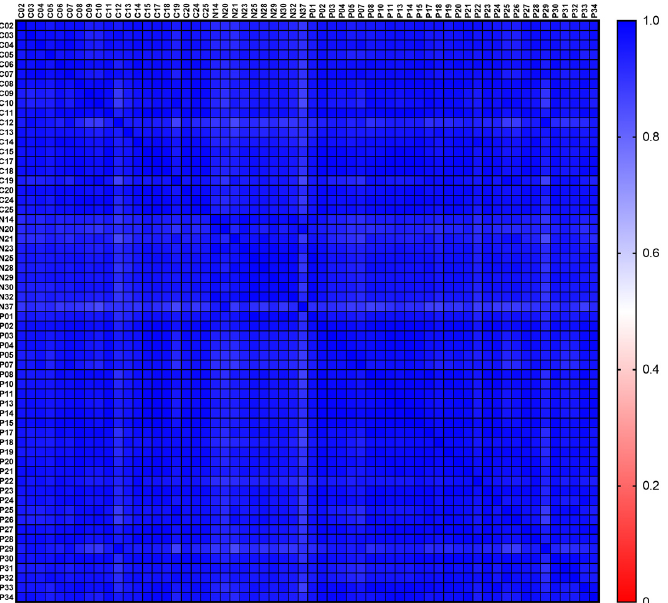
Figure 1. Normalized sample-to-sample correlation matrix. The spearman r value legend ranges from blue (1.0) over white (0.5) to red (0.0). For all samples the spearman r values ranged from 0.86– 0.99, indicating strong correlation.